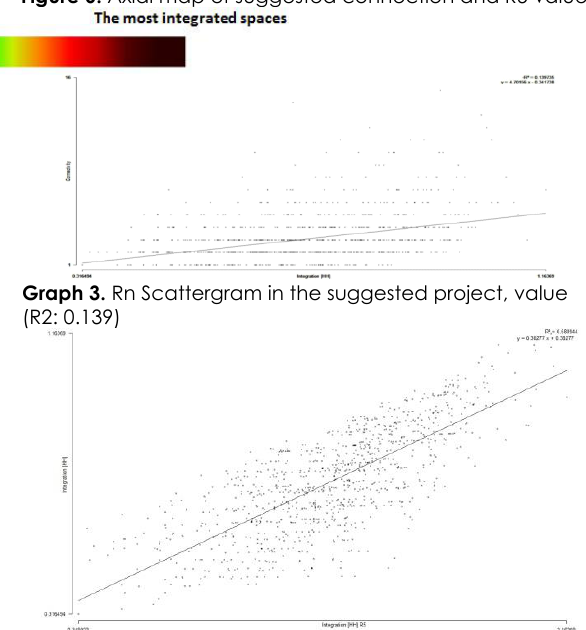
Figure 5. Axial map of suggested connection and Rn values. Figure 6. Axial map of suggested connection and R5 values